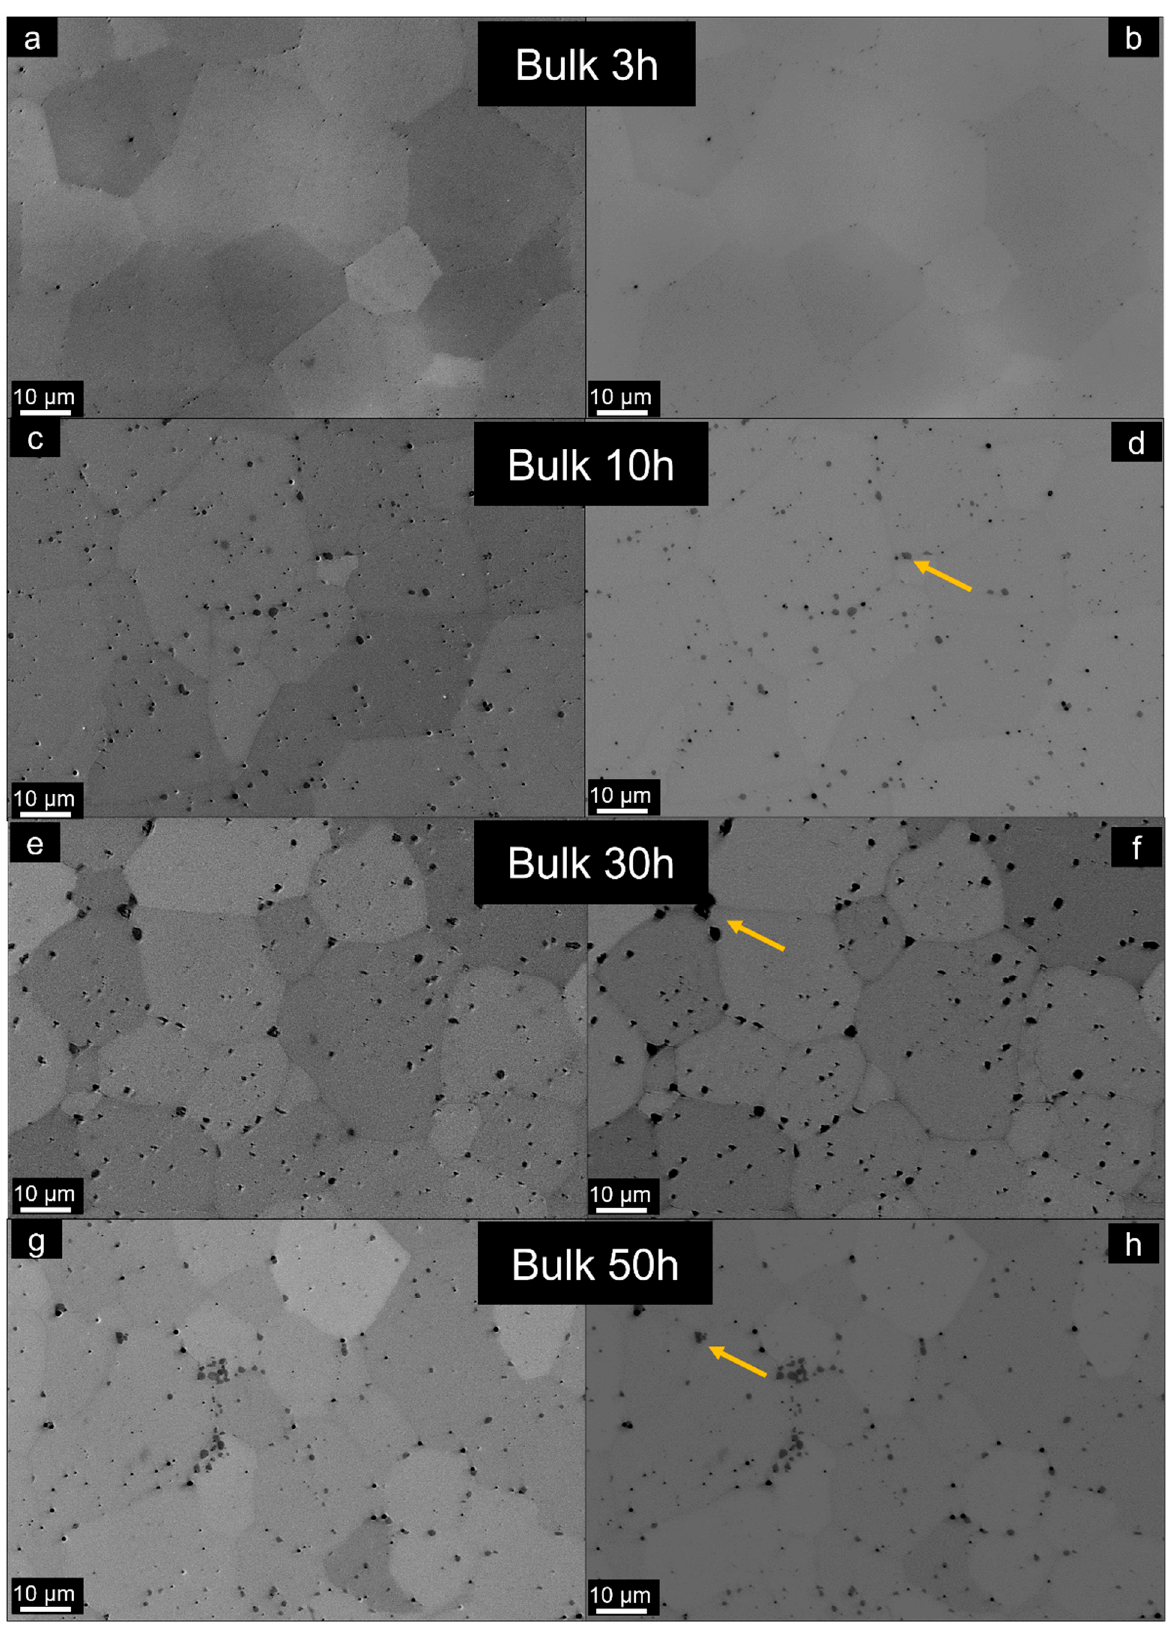
Figure 6. SEM micrographs of the Al 0.3 NbTa 0.8 Ti 1.5 V 0.2 Zr sintered bulks produced with different powder milling times in SE (left column) and BSE (right) modes, respectively: ( a , b ) 3 h, ( c , d ) 10 h, ( e , f ) 30 h, ( g , h ) and 50 h. The yellow arrows denote the oxide and carbide particles formed due to contamination.